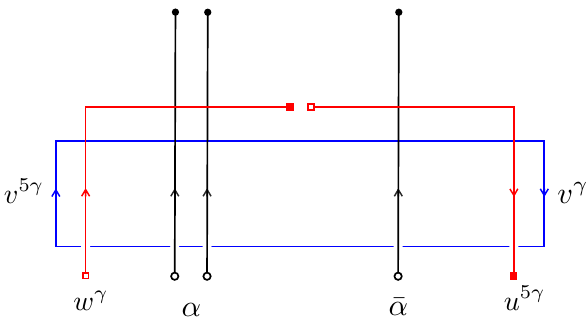
Figure 9 . The matrix part of the octagon transition is obtained by contracting two hexagon matrix parts, here standing on the left and on the right. Each open string represents a magnon (cid:31) , with A _ A the SU(2 j 2) index standing at its left (right) endpoint, and each crossing stands for the action L ( R ) of the SU(2 j 2) S-matrix S , with the orientation (cid:12)xing what is incoming and what is outgoing. A loop forms when we identify two magnons and sum over their (cid:13)avors, as done here for the mirror magnon (closed blue line) shared among the two hexagons. (There is no distinction between one or (cid:12)ve mirror rotations at the level of the matrix part, such that the rapidity can be chosen to be the same all along the blue mirror loop.) The wrapped octagon matrix part is obtained by attaching the remaining open mirror lines (in red) together. For the contact term, we must (cid:12)rst act with the derivative @ w and then set the mirror magnons in the wrapping con(cid:12)guration w = v = u . It produces two types of contributions, depending on whether we di(cid:11)erentiate the mirror-mirror or the mirror- real interaction points. In the latter case, Yang-Baxter and unitarity moves allow us to disentangle the two (red and blue) mirror loops; the blue line factorizing out and giving a transfer matrix. In the former case, the two mirror lines are entangled through the mirror-mirror scattering